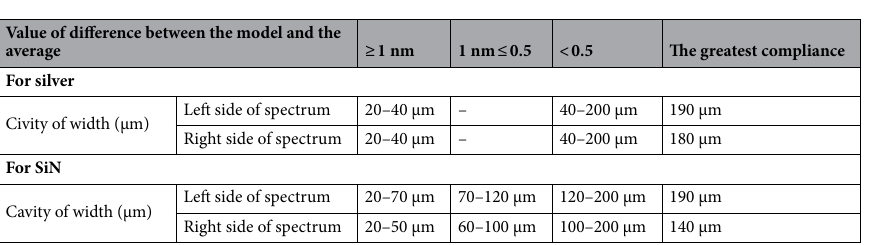
Table 2. Comparison between the theoretical model and the average data of 1310 nm.